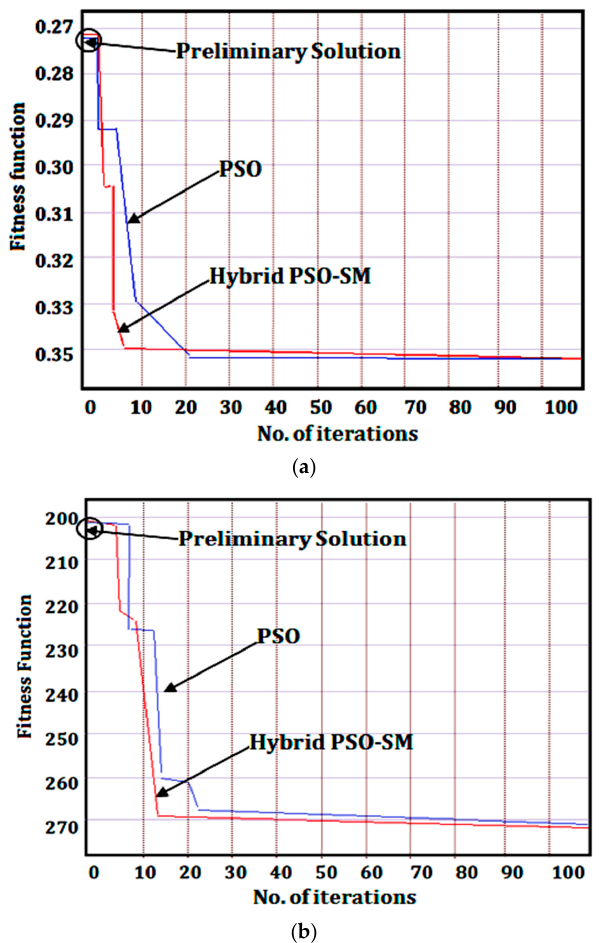
Figure 7. Convergence characteristics graphs for mono-objective optimization ( a ) minimum surface